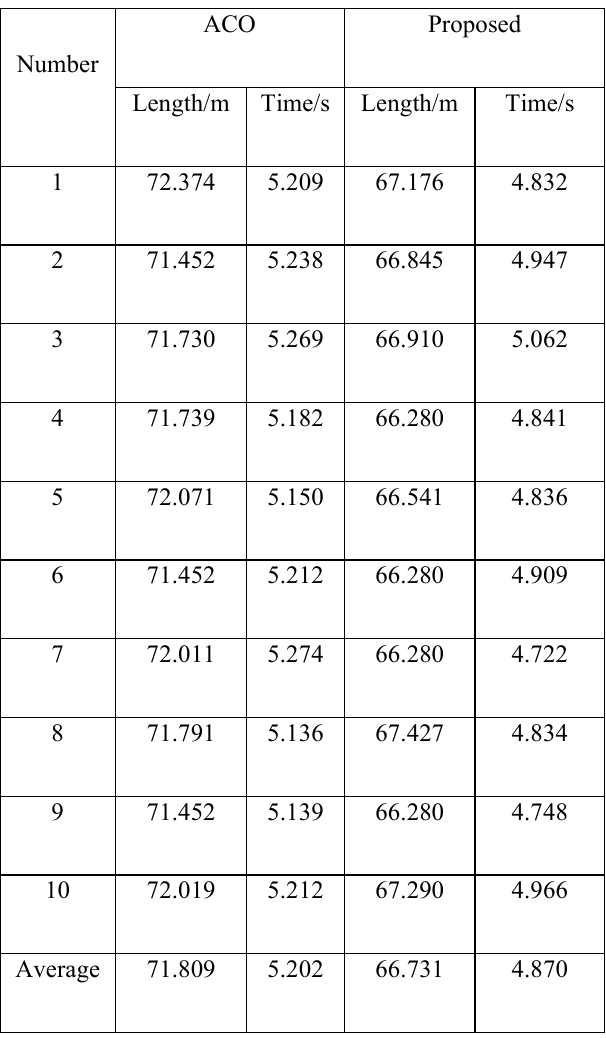
Table 2. Performance comparison between traditional ant colony algorithm and the proposed algorithm under environment 2